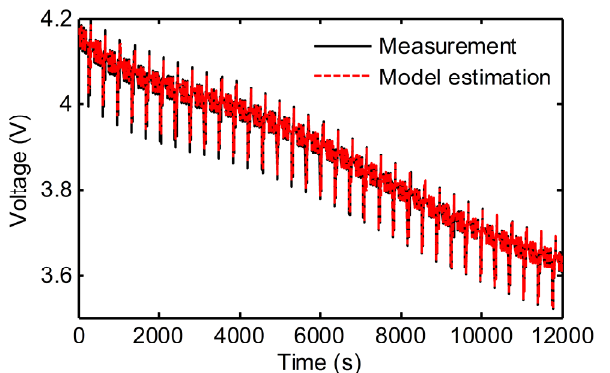
Figure 5. Measured and estimated voltage under DST cycles.